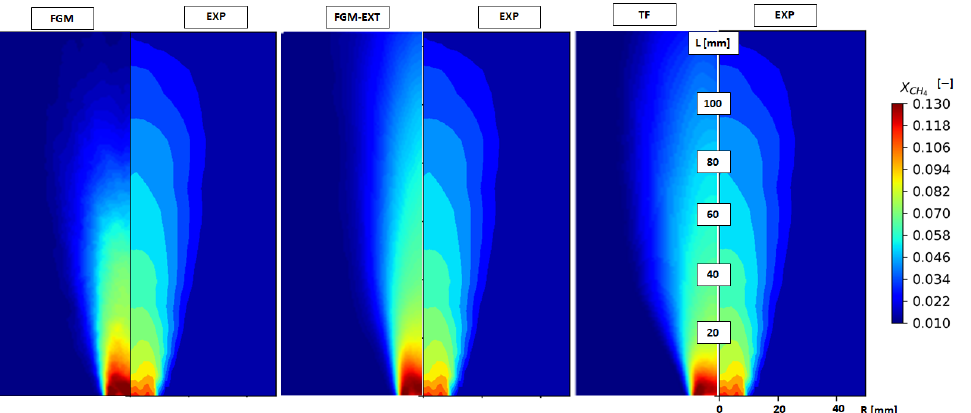
) ( left ) from FGM, FGM-EXT, and TF compared 2